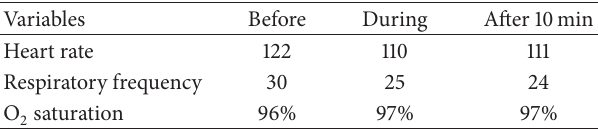
Table 1: Average parameters assessed during each physiotherapy